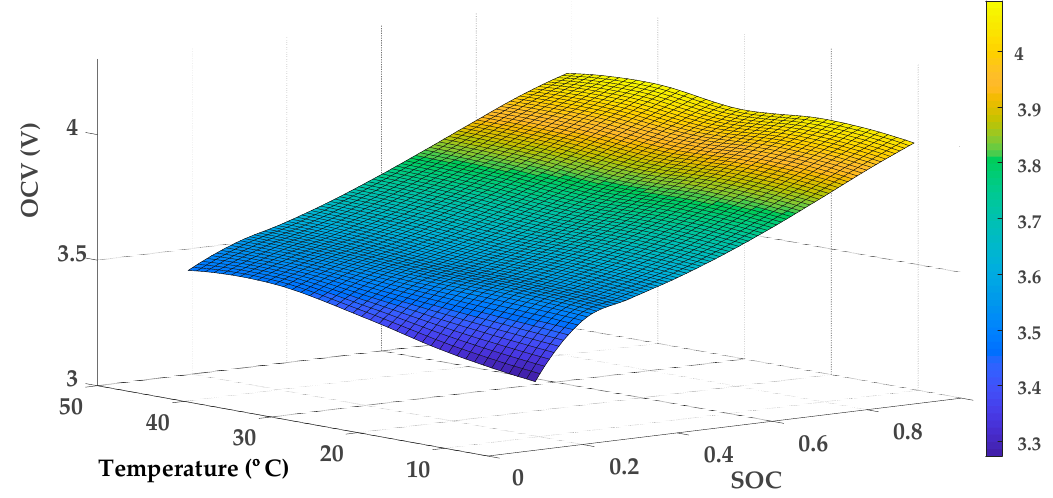
Figure 4. SOC–Temperature–OCV map.